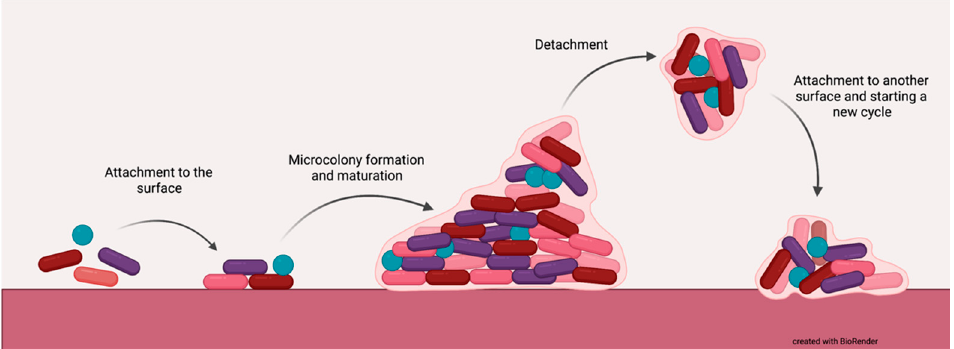
Figure 1. Cycle of biofilm formation.